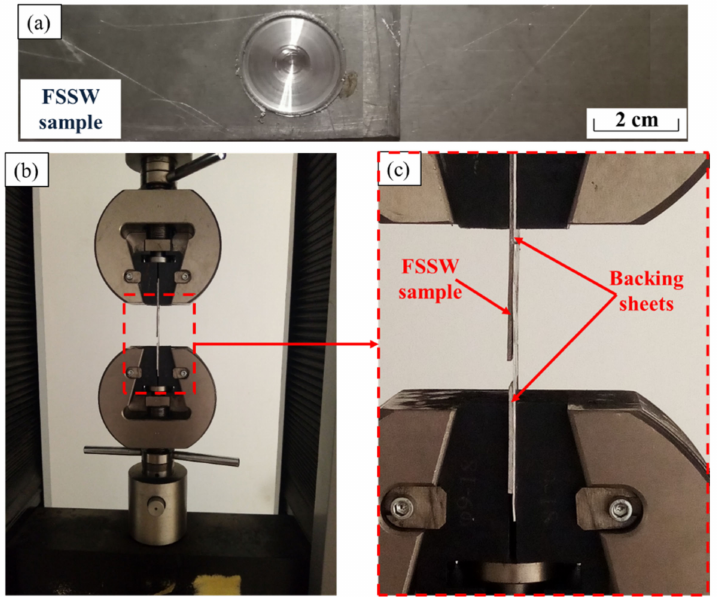
Figure 4. Photo image of ( a ) a dissimilar thickness AA6082-T6 lap joint, ( b ) setup of tensile/shear test of the spot-welded joint, and ( c ) higher magnification of ( b